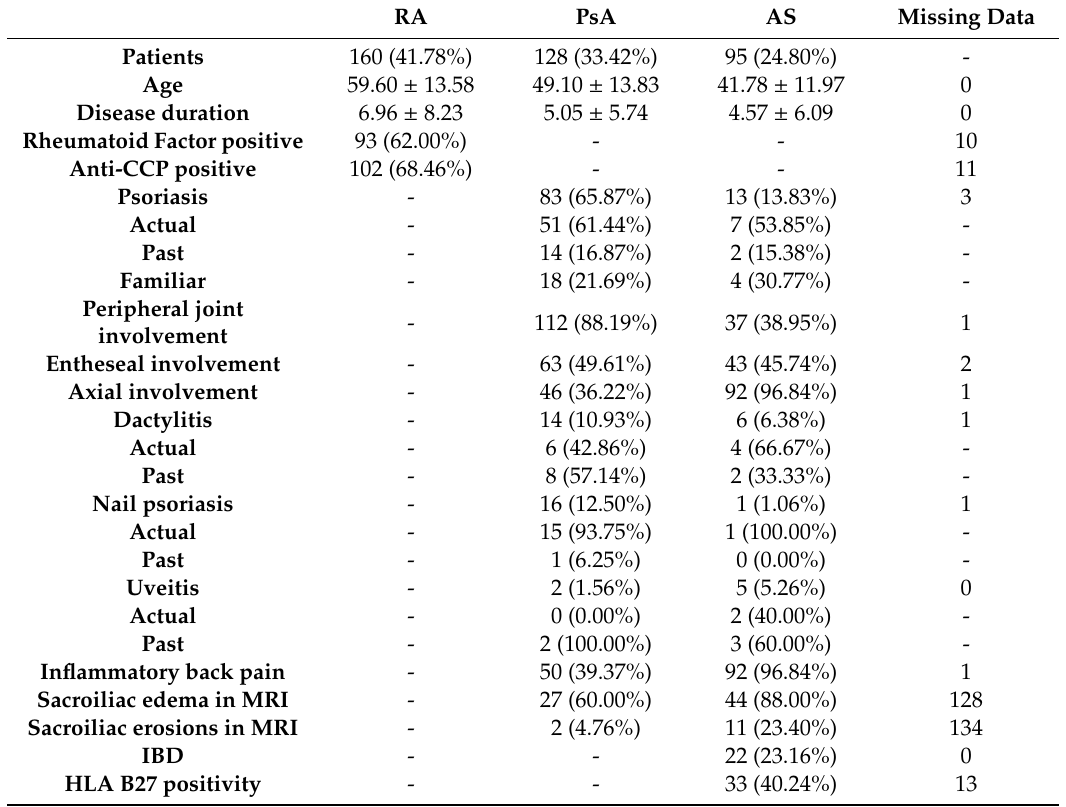
Table 1. Characteristics of the study